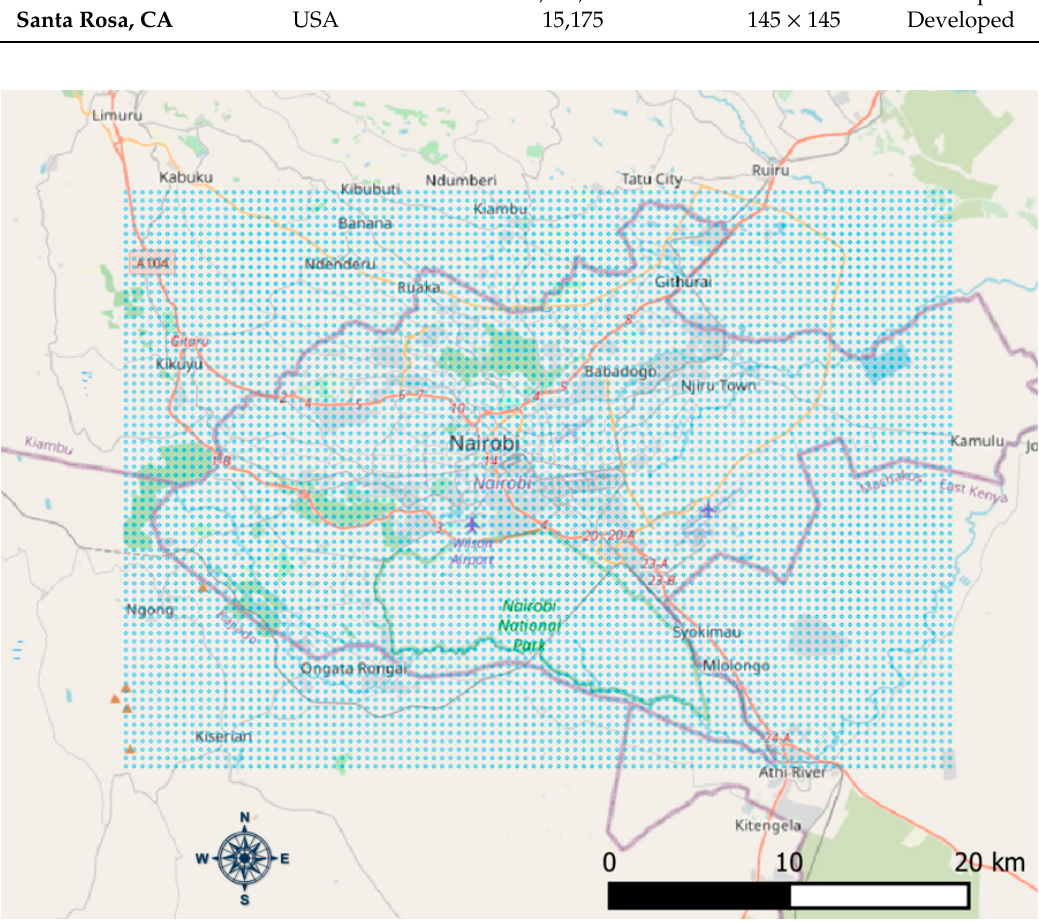
Figure 3. Grid points for the DNB temporal profiles for Nairobi, Kenya. It is an east–west north–south grid with center points 15 arc seconds apart. The Nairobit grid has 100 points east–west and 70 points north–south. Table 1. DNB temporal profiles extracted for this study.